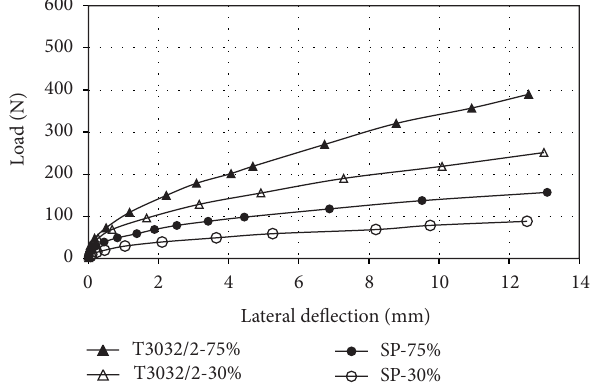
Figure 6: Lateral load versus lateral deflection (3 × 3 pile group; 𝑠/𝑑 = 3